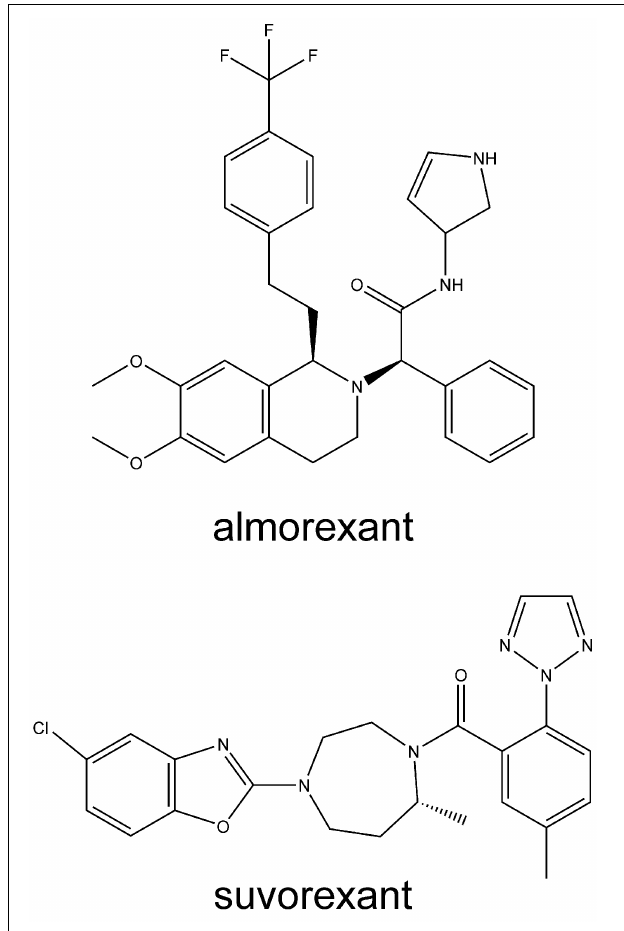
FIGURE 3 | Structures of some orexin receptor antagonists developed for insomnia. Structures are rendered using ChemBioDraw Ultra 13.0 (PerkinElmer, Waltham, MA,